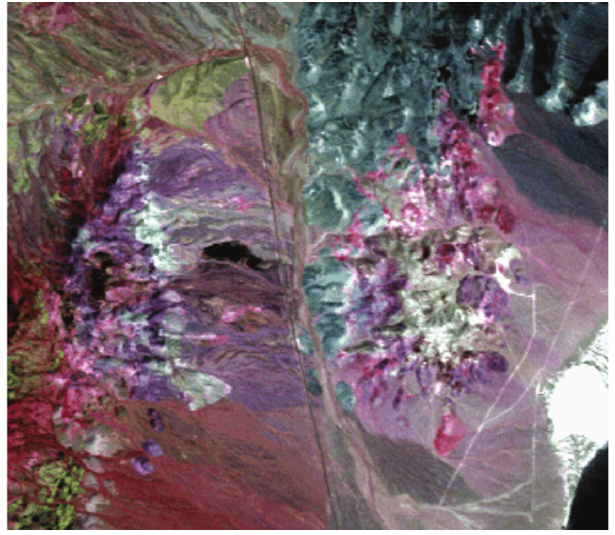
Figure 4. The AVIRIS Cuprite